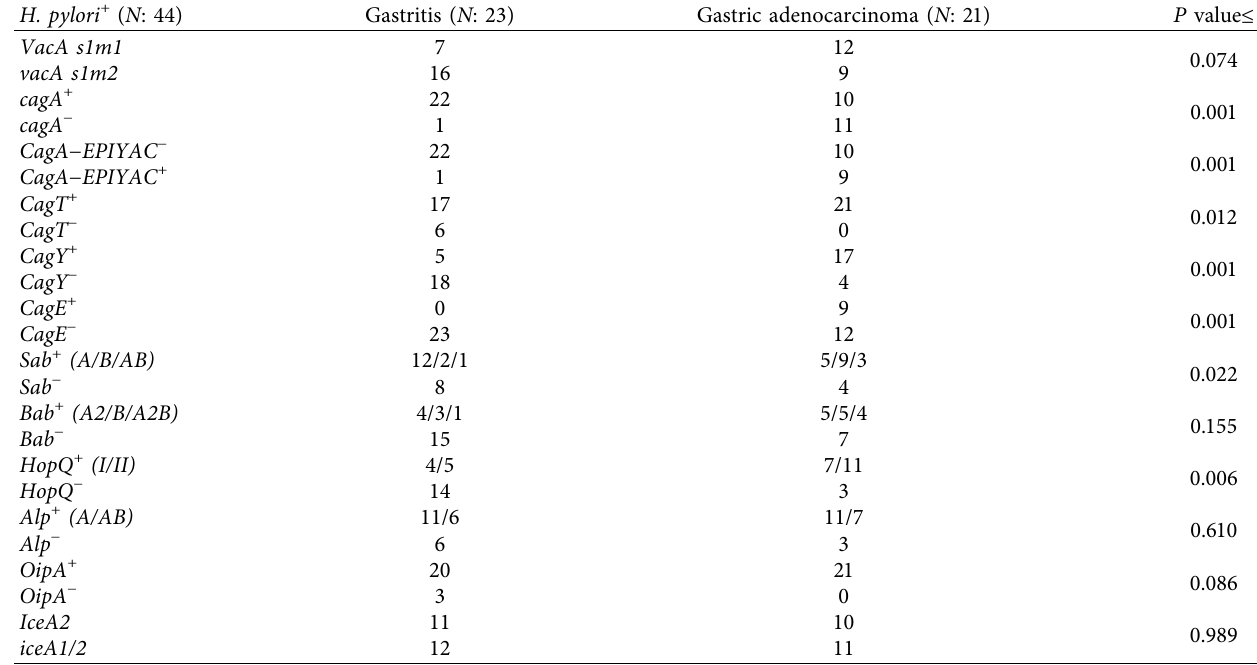
Table 7: Frequency of H. pylori genotypes in gastric epithelial cells of patients with gastritis and gastric adenocarcinoma. H. pylori + ( N : 44)